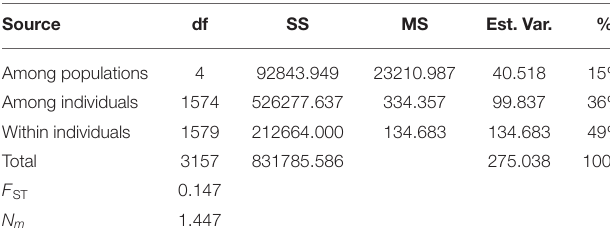
TABLE 3 | Analysis of molecular variance of the genetic variation among and within P. euphratica populations. Source df SS MS Est. Var.